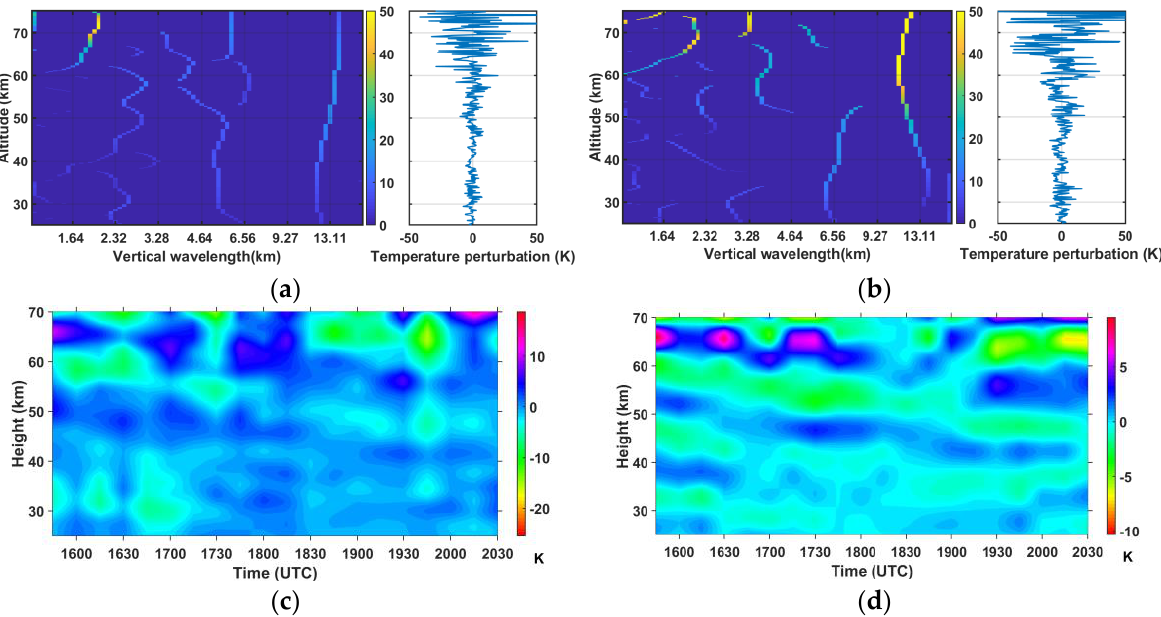
Figure 10. Spectral lines for the CWT maxima with values >5% of the maximum CWT-coefficient ab- solute value derived from 15 min lidar temperature perturbation profiles on ( a ) 9 October at 1835 UTC (2235 LST) and ( b ) 10 October at 1645 UTC (2045 LST); Height-time variation of perturbations on 9 October with vertical wavelengths ( c ) >5 km and of ( d ) 9.6–19.2 km.